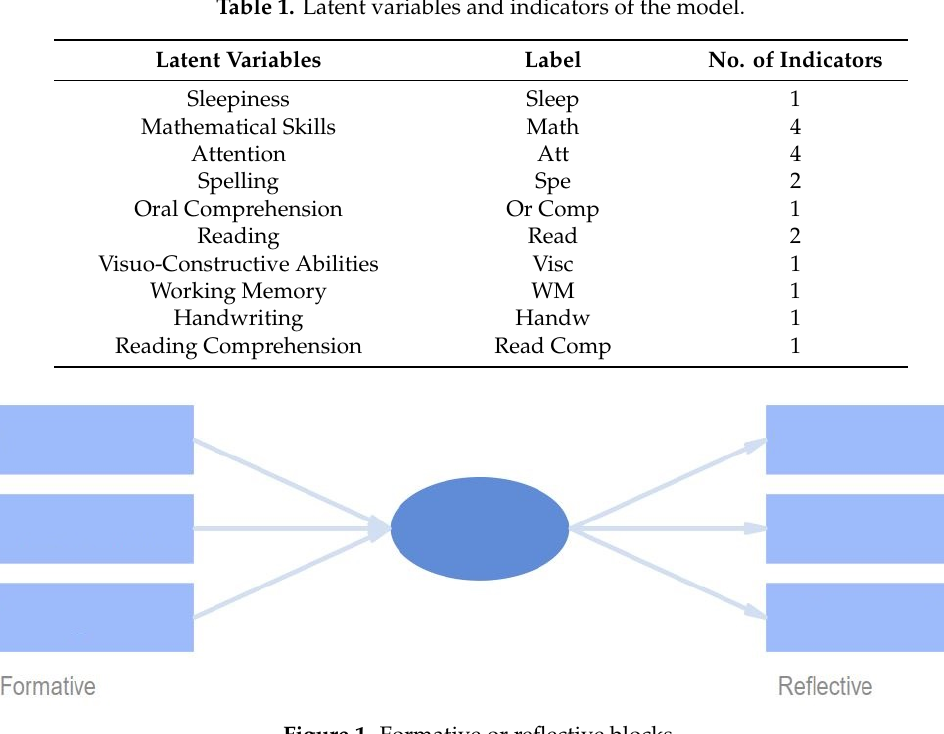
Figure 1. Formative or reflective blocks.